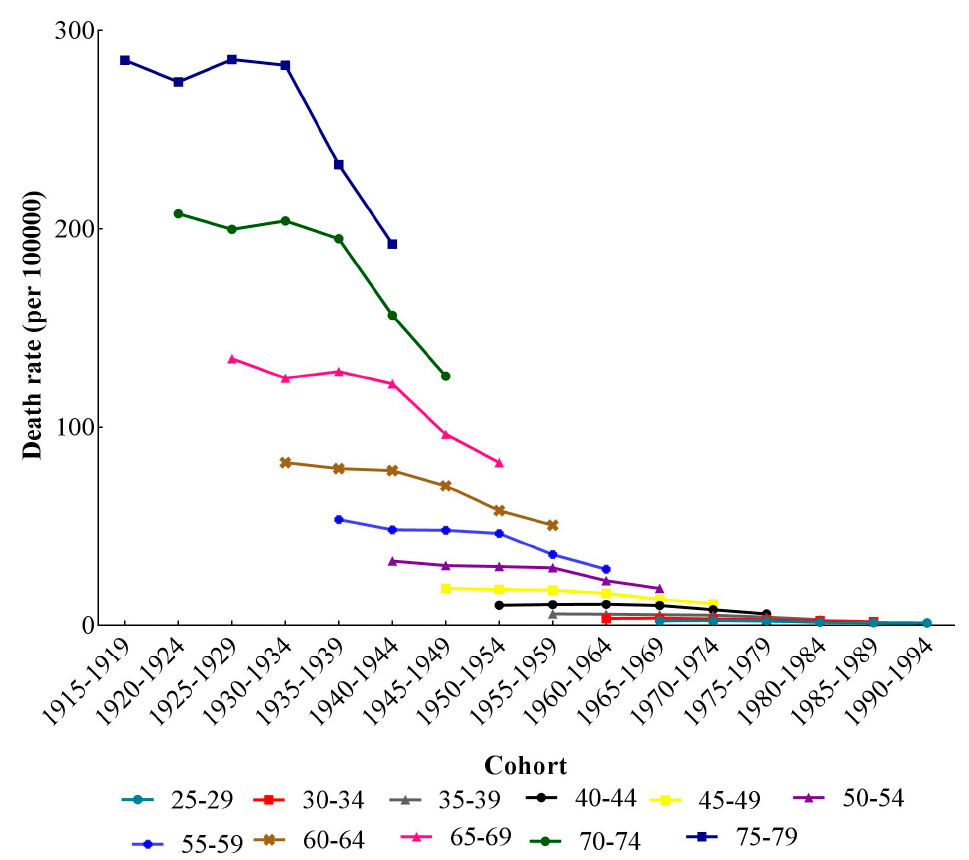
Figure 4. Cohort-based variation of age-specific stroke mortality-PM 2.5 .